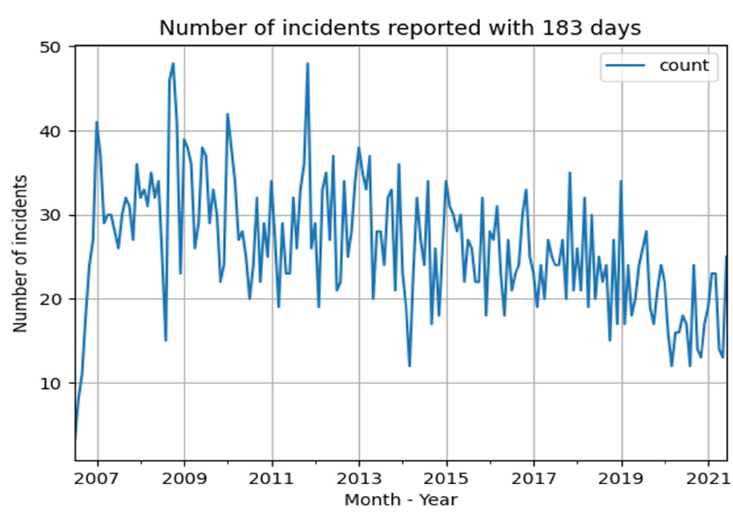
Figure 4. Number of incidents per month, with a reporting time of less than 183 days with date of incident before 1 July 2021.